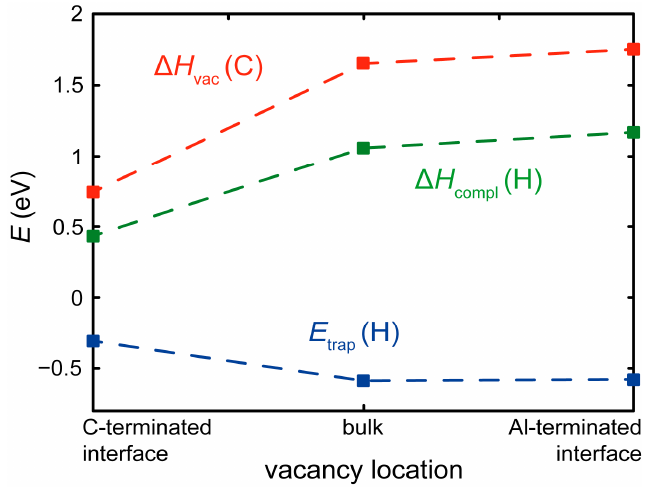
Figure 8. C vacancy formation energy (shown in red), H trapping energy within the vacancy (shown in blue) and their combination, i.e., the H–vacancy complex formation energy, (shown in green) for three different positions of vacancies. Note that trapping of H by vacancies near C-terminated interfaces is energetically the most favorable.